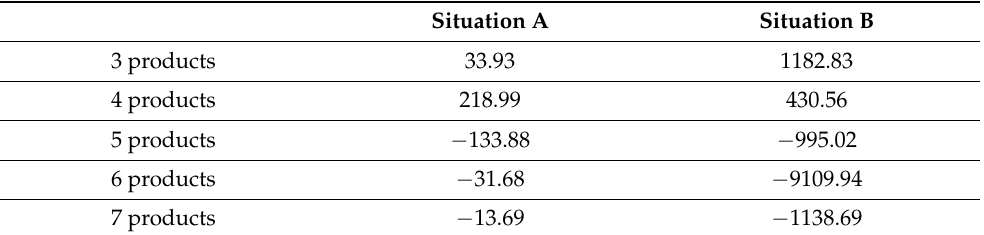
Table 5. The difference between total compensation negotiated via E-NeGotiAtion and via e-mail.